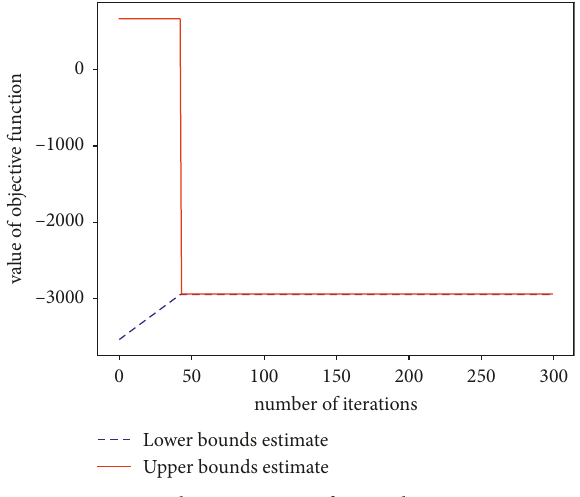
Figure 9: Evolution process of LB and UB estimate.